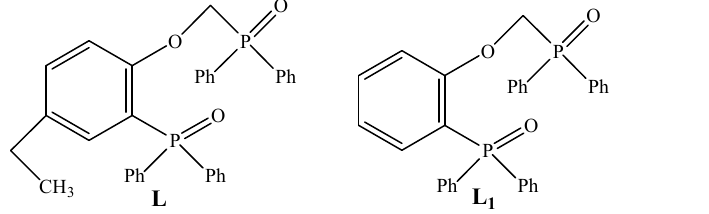
Figure 1. Structural formulas of the studied compounds.